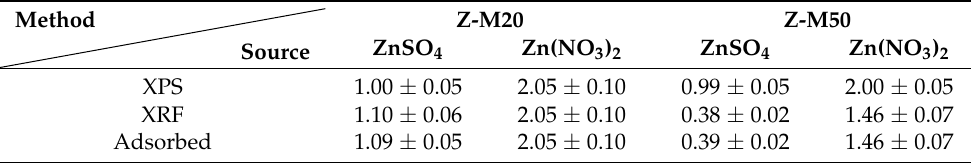
Table 5. A comparison of Zn content in mg · g − 1 ± standard